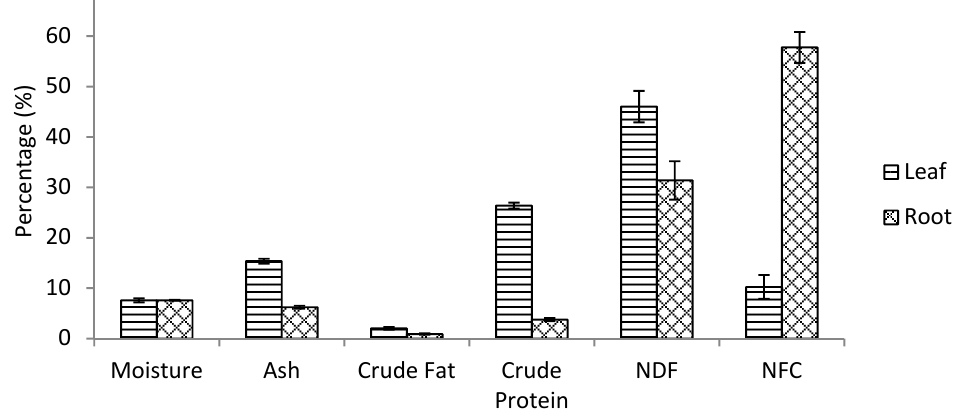
Figure 1. Percentage nutritional composition of the leaf and root of R. crispus. Non-Fibre Carbohydrates (NFC), Neutral detergent fibre